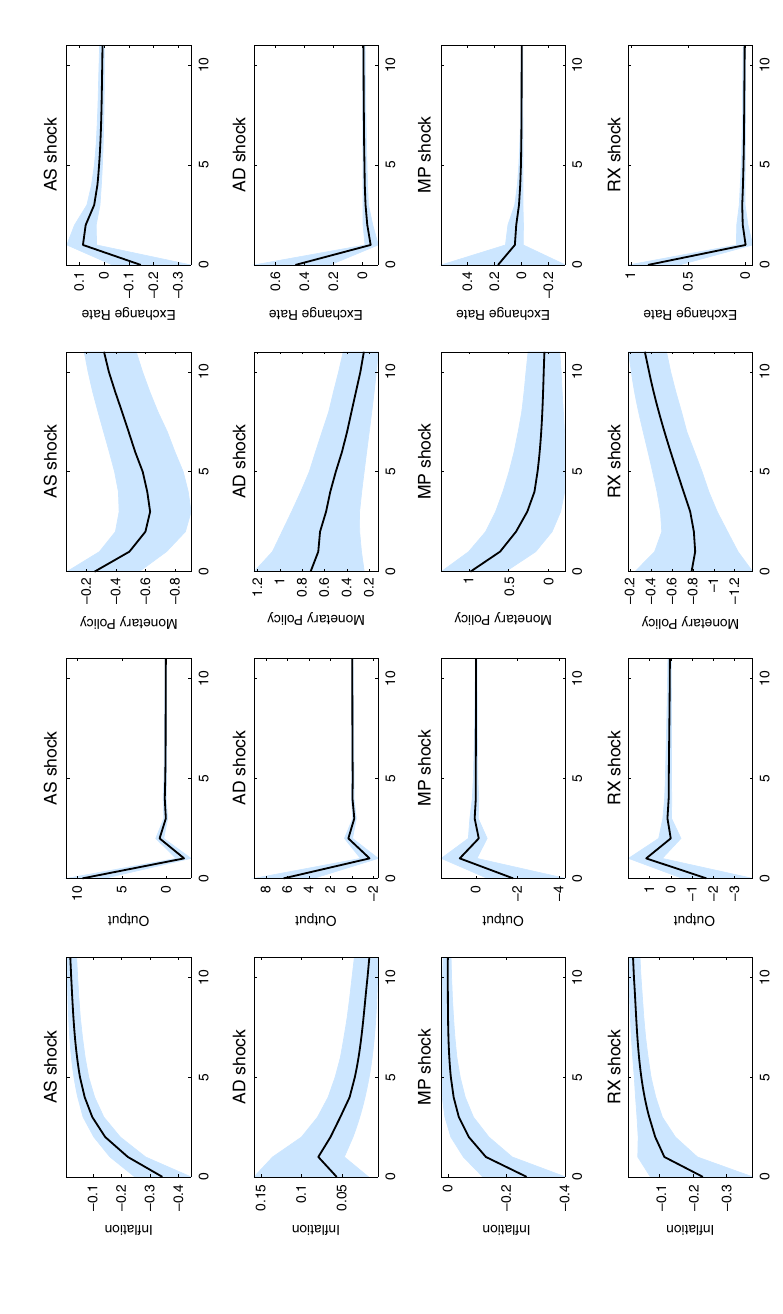
Figure A3. Impulse responses of Model 2 (sign restriction